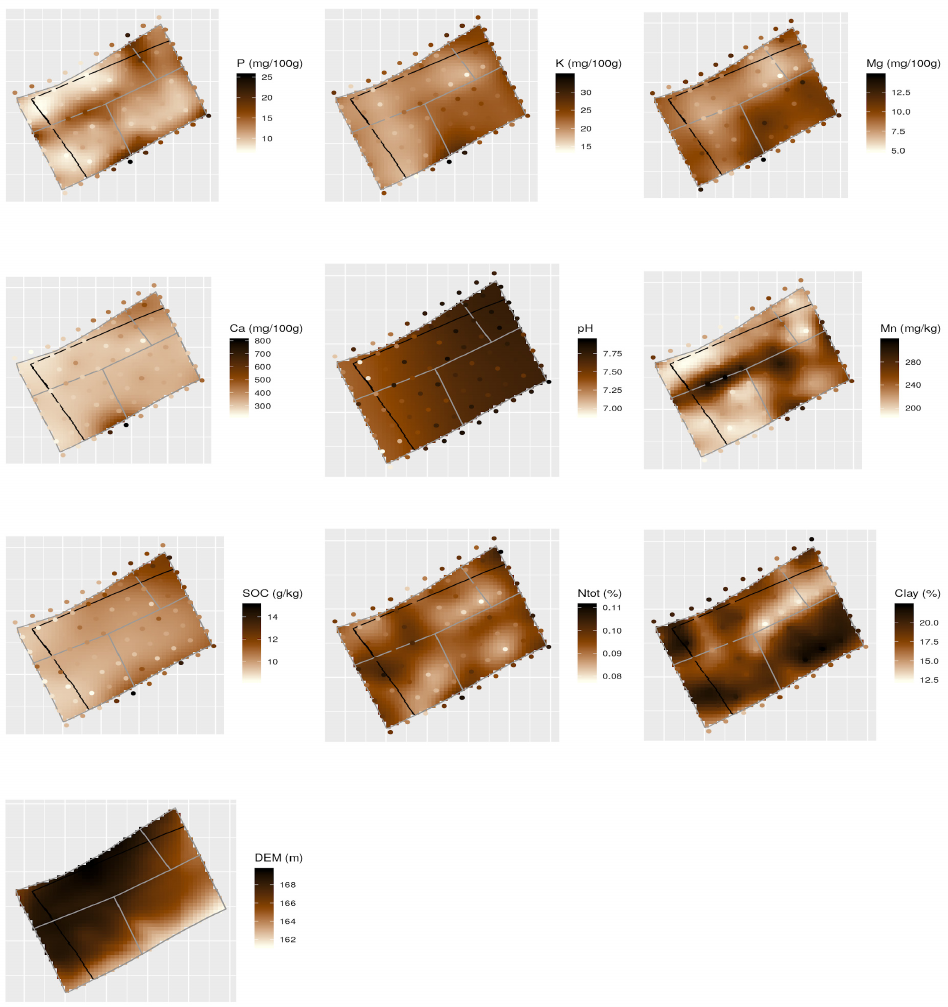
Figure 4. Maps of interpolated soil variables by ordinary kriging and DEM map. Points represent the location of the topsoil sampling, and gray lines show the delineation of the previous four parcels (A, B, C, and D) of the former field layout which were merged in 2017 (see Figure 1). The black border delineates the study area which is used as input in the CI-forest algorithm.